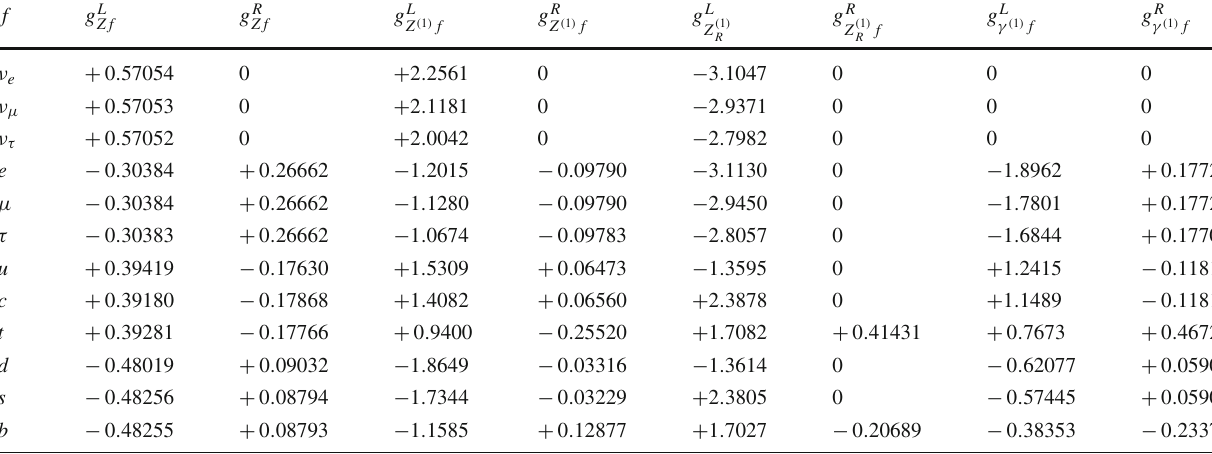
Table 6 Z (cid:3) couplings of fermions for θ H = 0 . 10, c l , c q < 0. The same unit as in Table